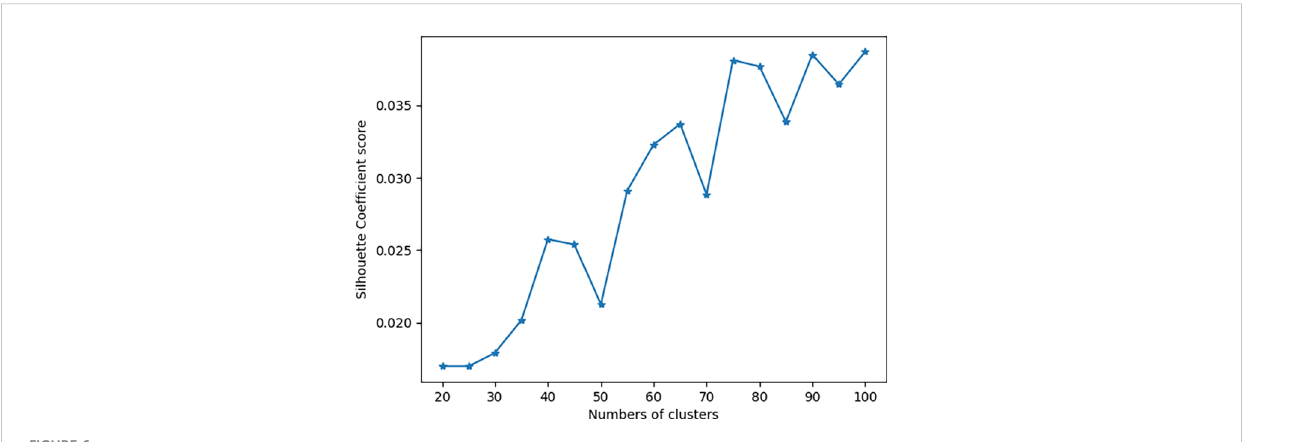
FIGURE 6 K-means clustering experiment